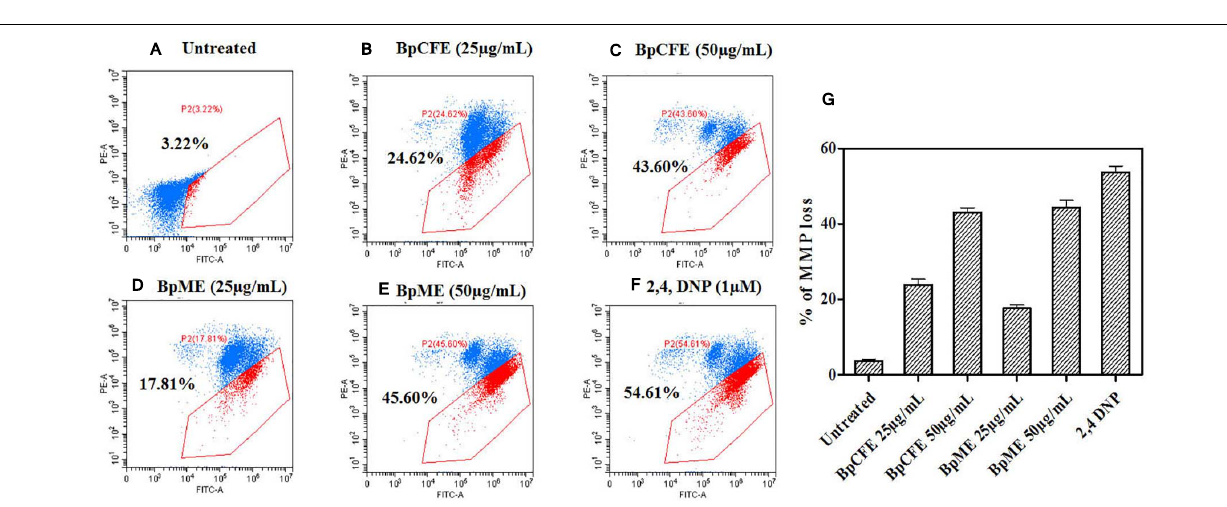
FIGURE 7 | Determination of apoptosis through loss of mitochondrial membrane potential in HeLa cells induced by Bp culture extract and quantified by JC-1 monomer percentage. (A) Untreated (B) culture filtrate extract (25 µ g/ml), (C) culture filtrate extract (50 µ g/ml), (D) mycelial extract (25 µ g/ml), (E) mycelial extract (50 µ g/ml), (F) 2,4-DNP, and (G) statistical analysis of loss of mitochondrial membrane potential acquired in a flow cytometer. The experiments were conducted three times, and results are obtained from mean ±